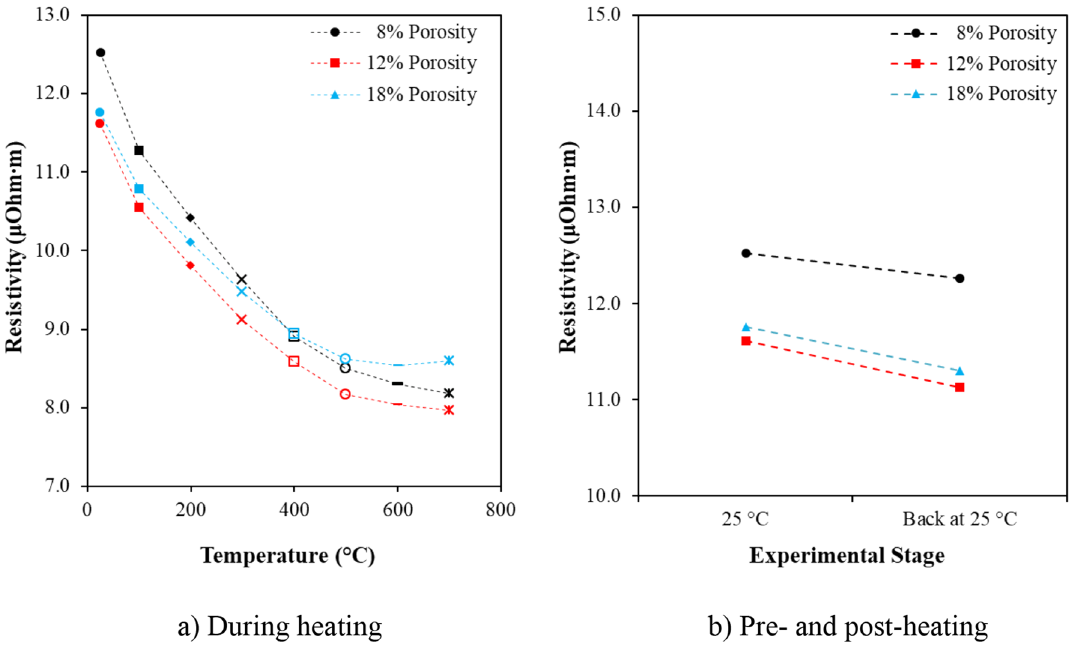
Fig. 3 a Resistivity change with temperature for specimens containing various amounts of porosity; b comparison between pre- and post- heating of the test specimens